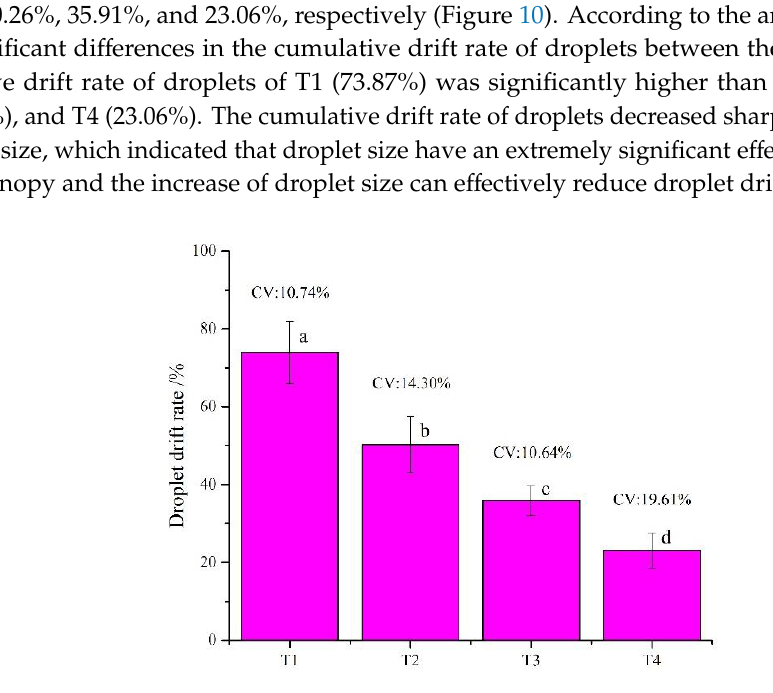
Figure 10. Cumulative drift rate of droplet. Bars with different letters are significantly different, Duncan’s test, p -level < 0.05.